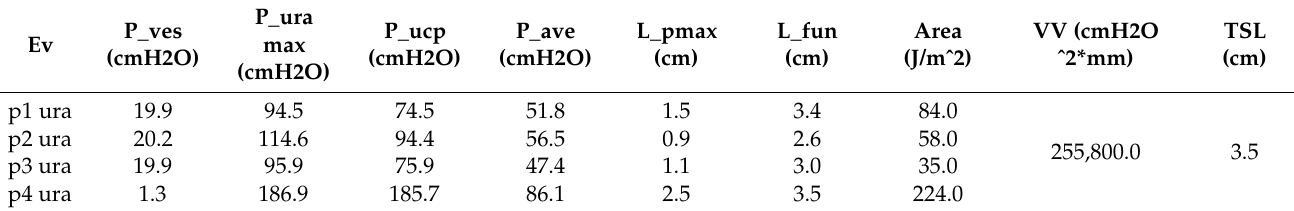
Table 1. Urethral pressures measurements data.